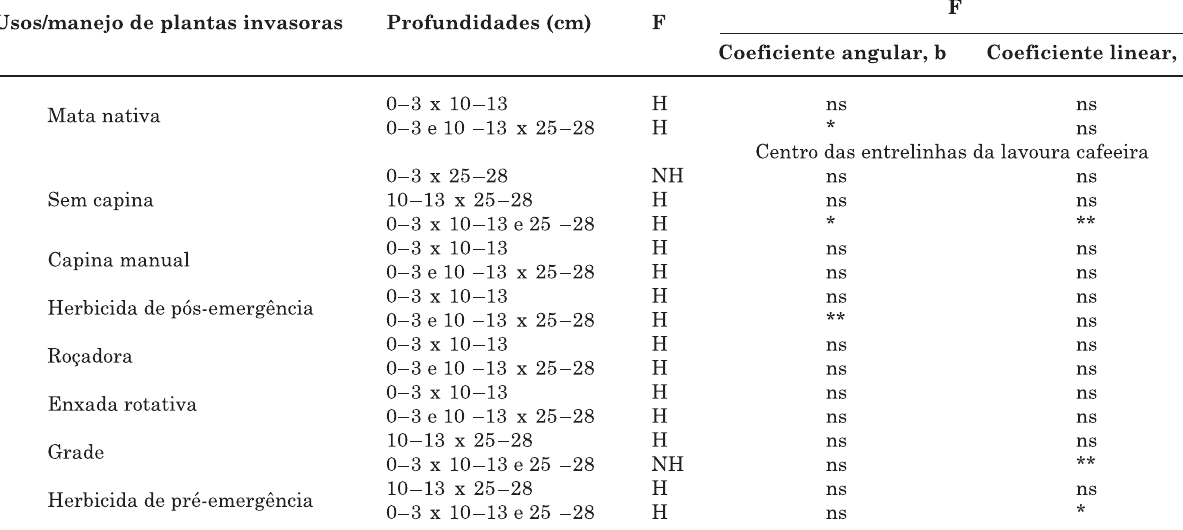
(1) Snedecor & Cochran (1989). (2) σ = 10 (a + b θ ) ; NH: não homogêneo; H: homogêneo; **significativo a 1 %; *significativo a 5 %; ns: p não